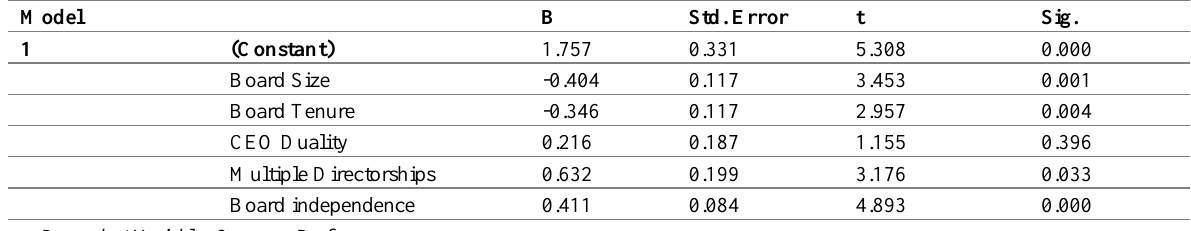
Table 8: Model Regression